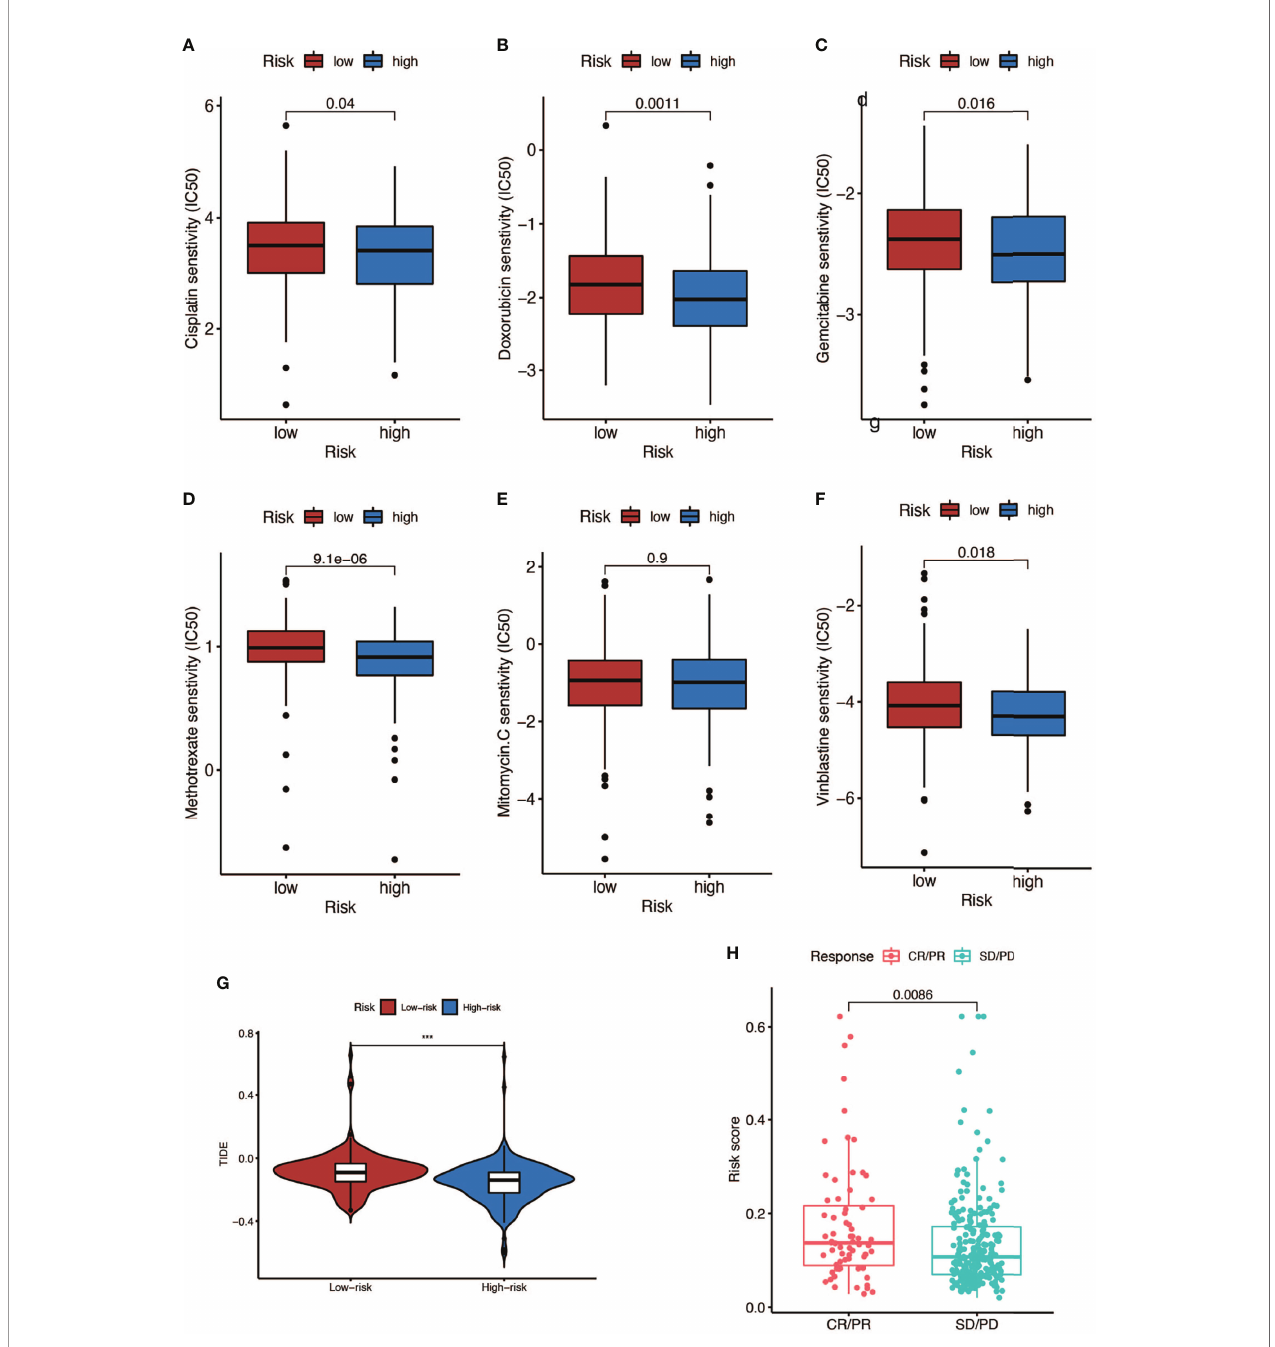
FIGURE 9 | Response to chemotherapy and immunotherapy of patients in the high- and low-risk-score groups. (A – F) Comparison of chemotherapy drugs sensitivity in high- and low-risk-score patients including cisplatin, doxorubicin, gemcitabine, mitomycin C, and vinblastine. (G) TIDE scores of high- and low-risk- score patients (*** P < 0.001). (H) Risk scores of CR (complete response)/PR (partial response) patients and SD (stable disease)/PD (progressive disease) patients after PD-L1